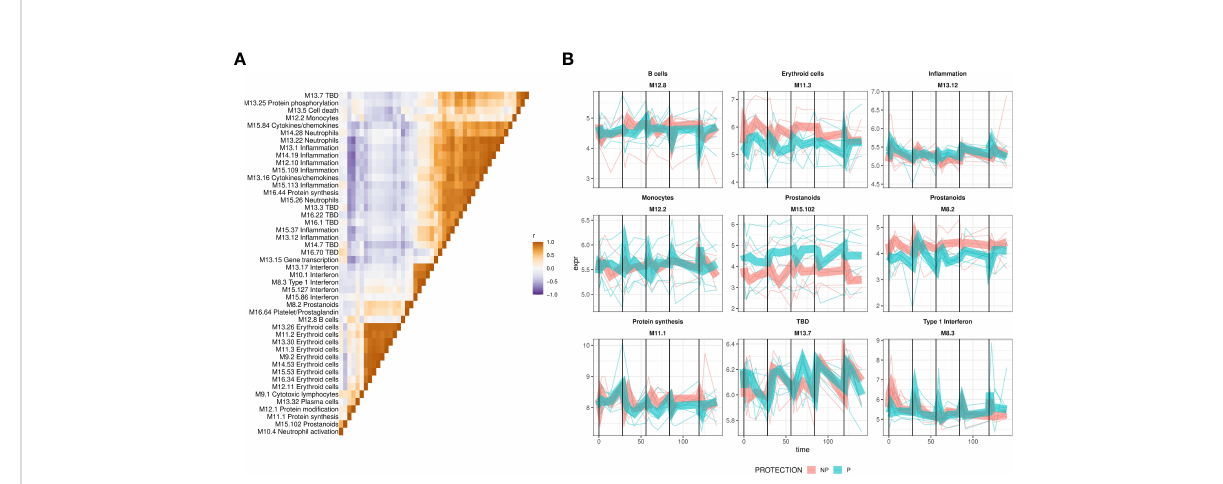
FIGURE 4 Expression dynamics of protection-associated BTMs. Expression of protection-associated BTMs identi fi ed by GSEA was calculated as the average of BTM gene expression and used to create a BTM correlation matrix. (A) The BTM correlation matrix. Expresison of protection associated BTMs, identi fi ed by GSEA, was calculated as the average of BTM gene normalized expression, and pairwise Pearson correlation coef fi cients calculated and used as a basis for hierarchical clustering of the matrix. Colors show BTM-BTM correlation coef fi cients (Pearson ’ s r), and BTMs ordered identically on the x- and y-axes by hierarchical clustering of the correlation matrix. (B) Averaged expression of representative BTMs from subclusters in (A) plotted with lines representing individuals BTM expression, colored by protection status. Protection group average expression shown as thick